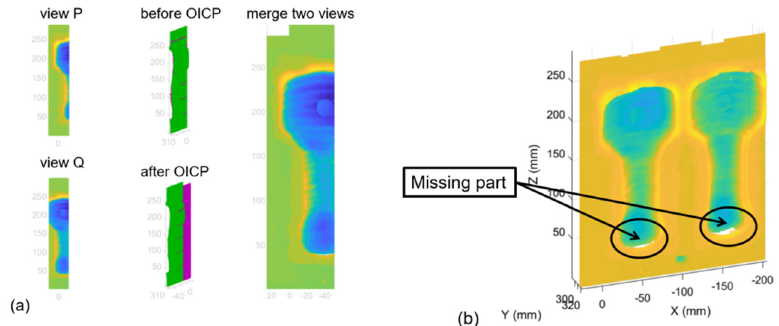
Figure 1. Merging process of the Offset Iterative Closest Point (OICP) algorithm. ( a ) Rigid transfor- mation and merging of two point clouds; ( b ) rigid transformation and merging of multiple point clouds and missing part.